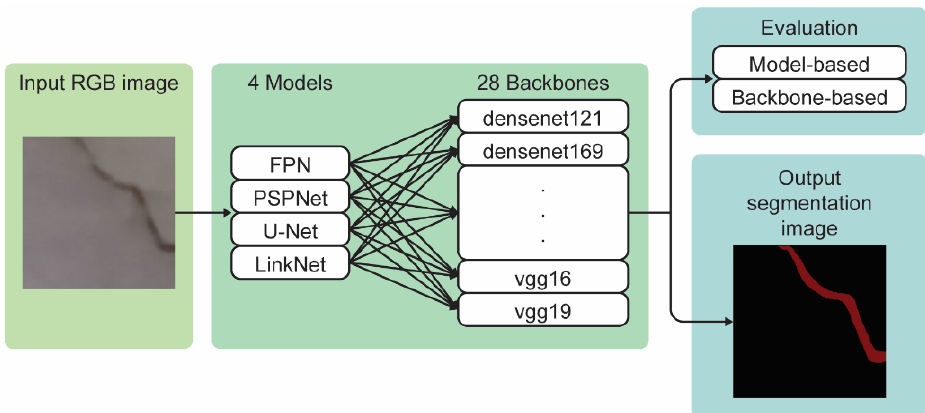
Figure 6. An illustration of the proposed methodology. Input images are provided for the proposed segmentation architecture, examining the combination of 4 semantic segmentation models with 28 feature extraction networks; results include the output segmentation image and the numerical experimental results of the models which are evaluated based on two different perspectives: (1) based on the model and (2) based on the backbone.